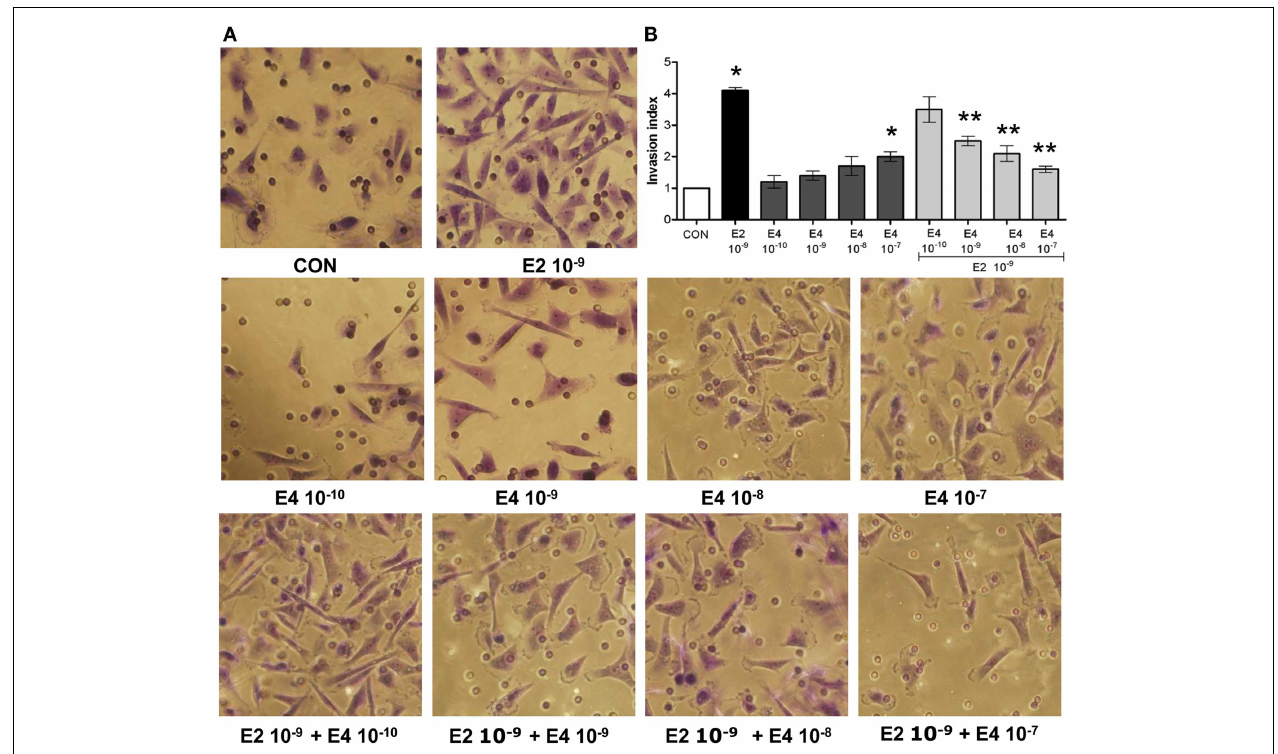
images in chambers with matrigel are shown. (B) A graphical representation of the invasion indexes in the different conditions is provided. Quantification was obtained by pooling the results from three separate experiments. In each experiments, 10 random microscopical fields were selected and the number of invading cells counted. Invasion indexes were calculated as detailed in the Section “Materials and Methods.” * p < 0.05 vs. control. ** p < 0.05 vs.